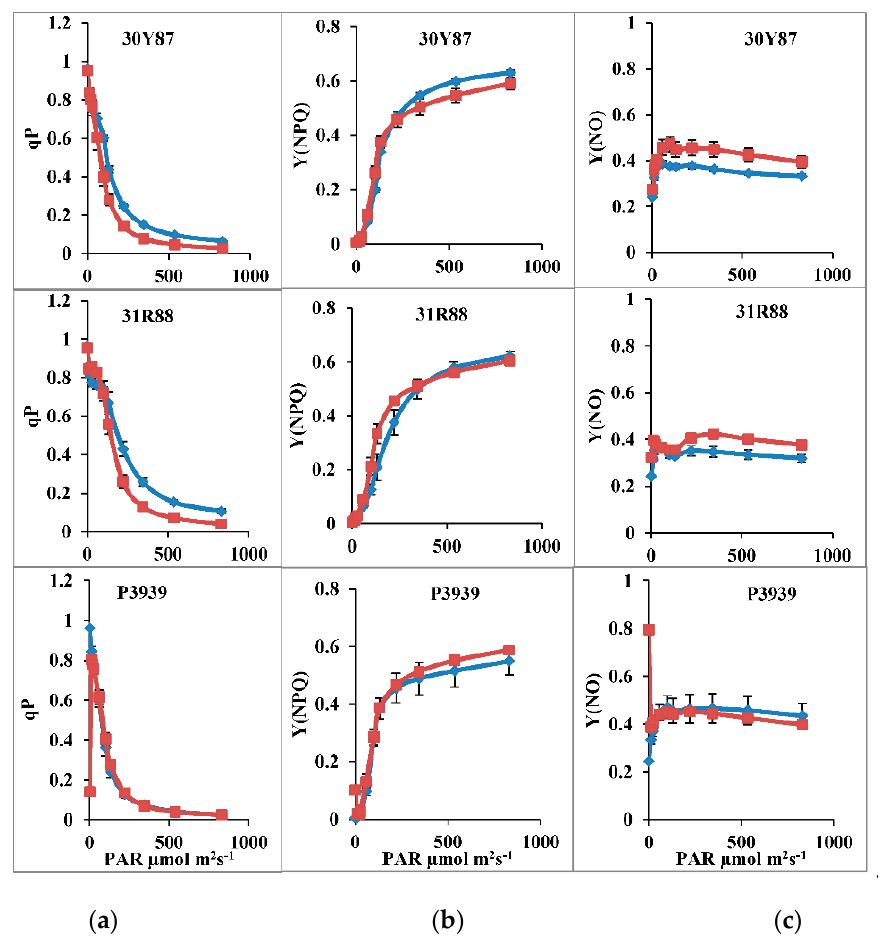
Figure 2. Changes in photochemistry qP, Y(NPQ), and Y(NO) of three maize hybrids, when two- week-old plants were subjected to three cycles of drought stress. ( a ) photochemical quenching (qP); ( b ) Fraction of energy dissipated as heat via the regulated nonphotochemical quenching mechanism [Y(NPQ)]; ( c ) Fraction of energy that is passively dissipated as heat and fluorescence [Y(NO)]. Blue lines are control, red lines with markers are water stress. Bars represent the calculated standard error (n = 4).